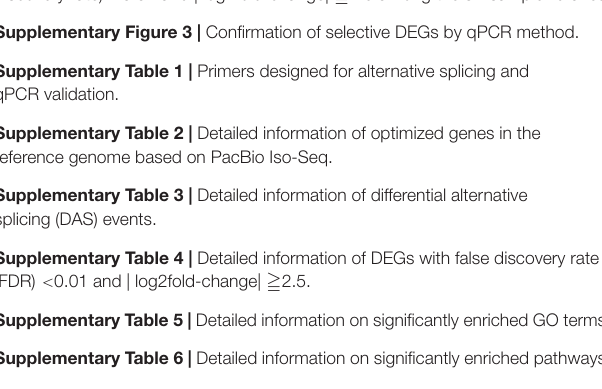
Supplementary Table 1 | Primers designed for alternative splicing and qPCR validation.